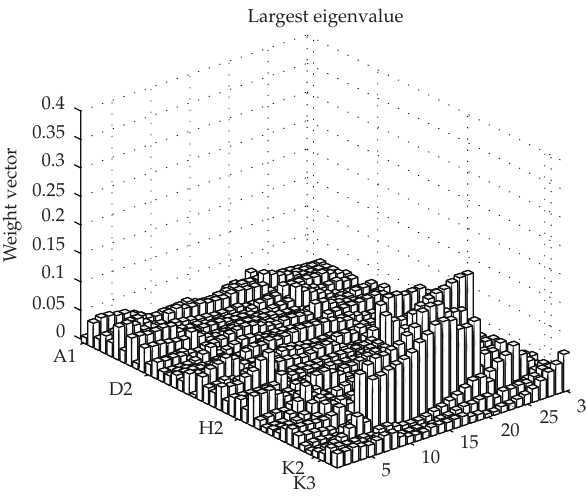
Figure 9: The pattern of P2P tra ffi c, monitored by A3, B1, C1, C2, and D1. For each peer in the group A1, D2, J5, K2, and K3, rate (cid:8) 25, starting time (cid:8) 125. Then peers of D2 leave at t (cid:8) 160 and peers of H2 join in at t (cid:8) 200 with rate (cid:8)